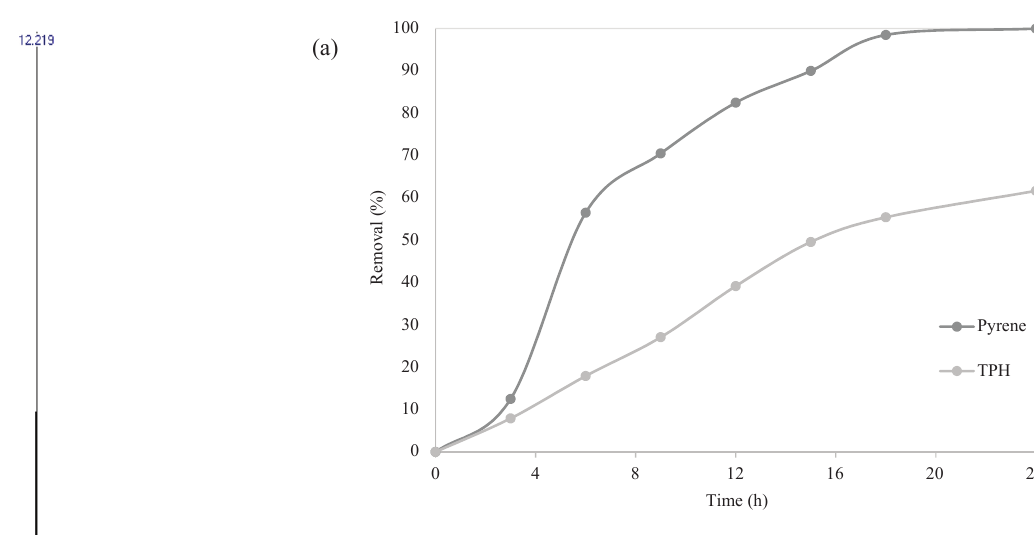
Fig. 4 – Comparison of pyrene and TPH removal using per- sulfate-assisted EK remediation in the same selected conditions (Tween 80: 20 mL kg –1 , pH: 7 ± 0.3, voltage: 1 V cm –1 ,